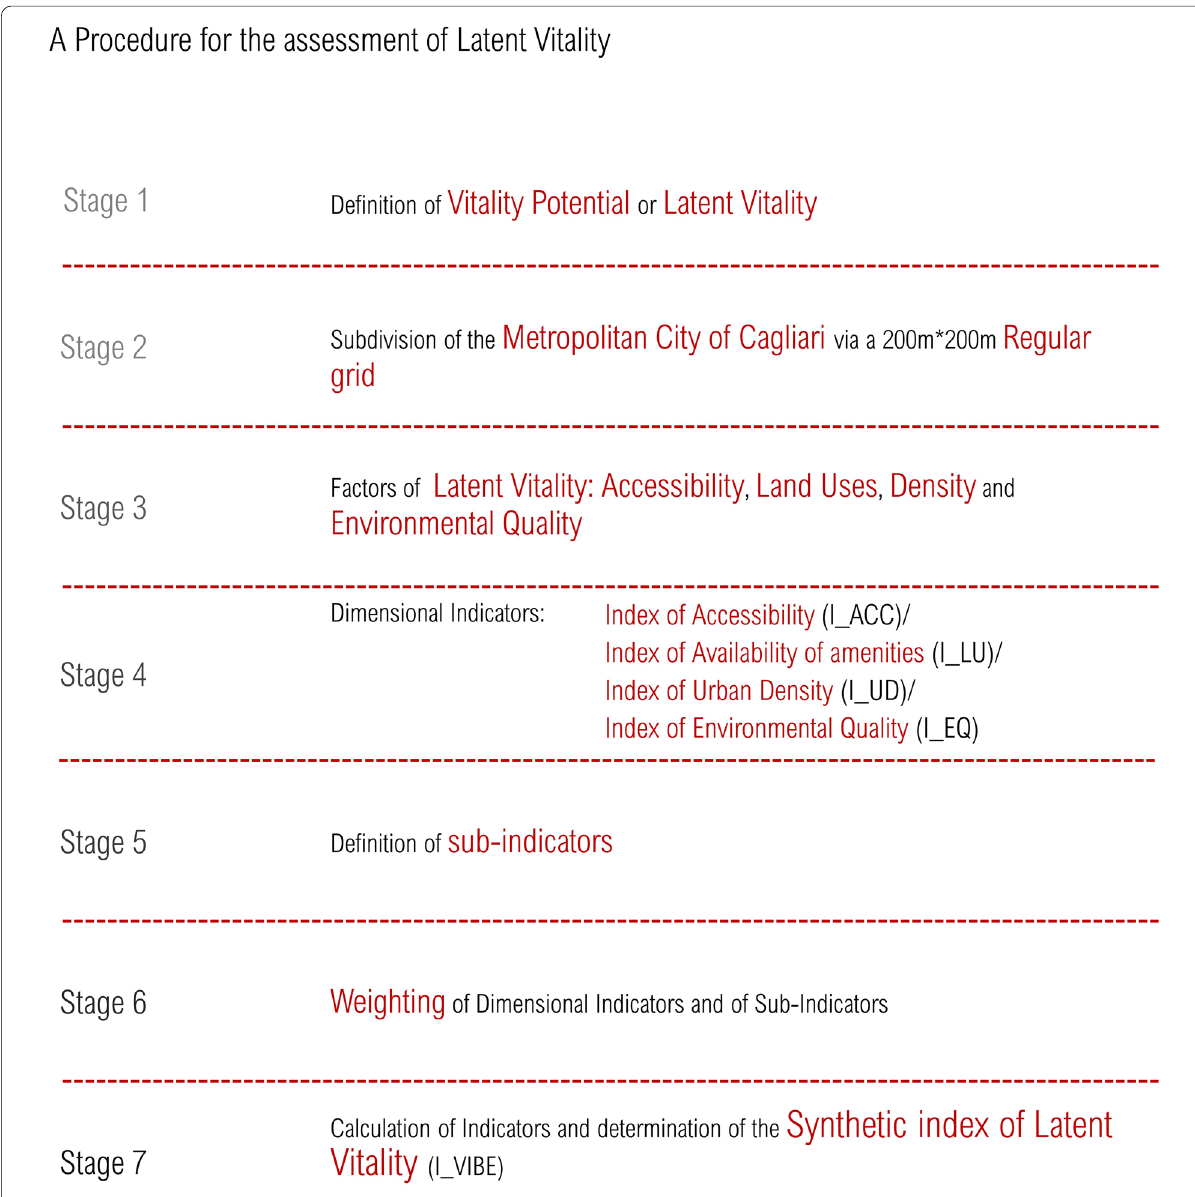
Fig. 1 Seven Stages articulation of the procedure for the analysis of latent